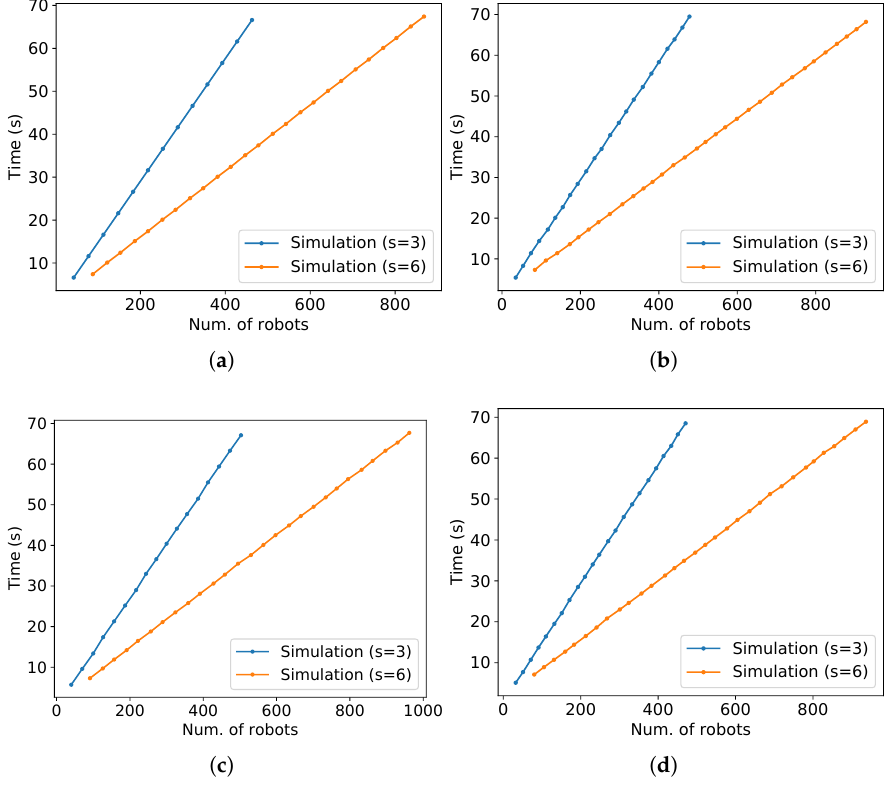
Figure 35. Time of arrival at the target of the last robot versus the number of robots for the same simulations in Figure 34. ( a ) θ = 0; ( b ) θ = π / 12; ( c ) θ = π / 6; ( d ) θ = 5 π /